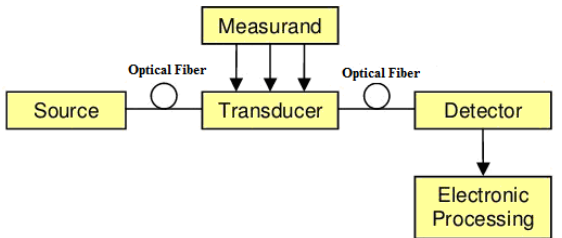
Figure 1. Basic components of a fiber-optical sensor system